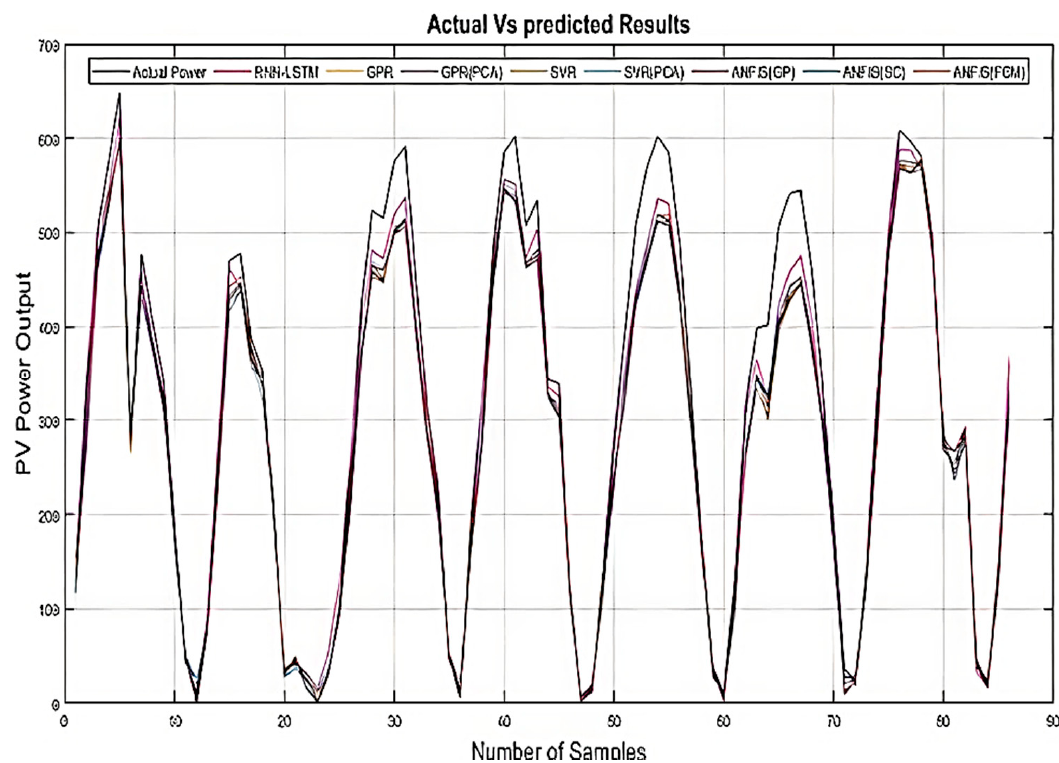
Figure 14. Comparison of prediction results for an m-si PV plant using various prediction methodologies.